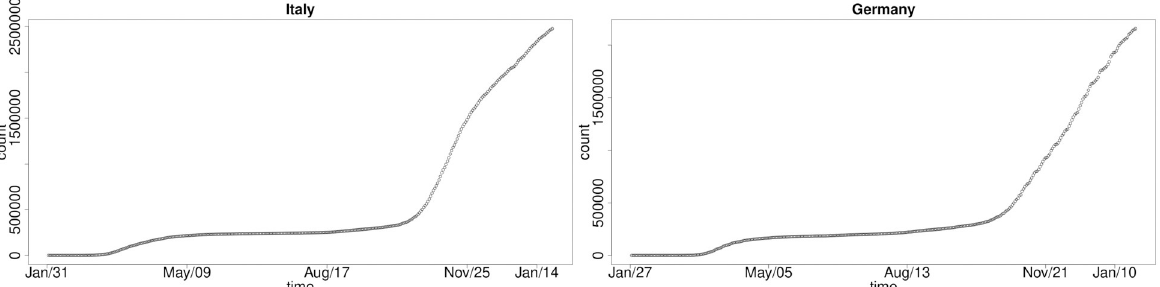
Fig 2. Cumulative COVID-19 national-level infections over time: Italy (left) and Germany (right).